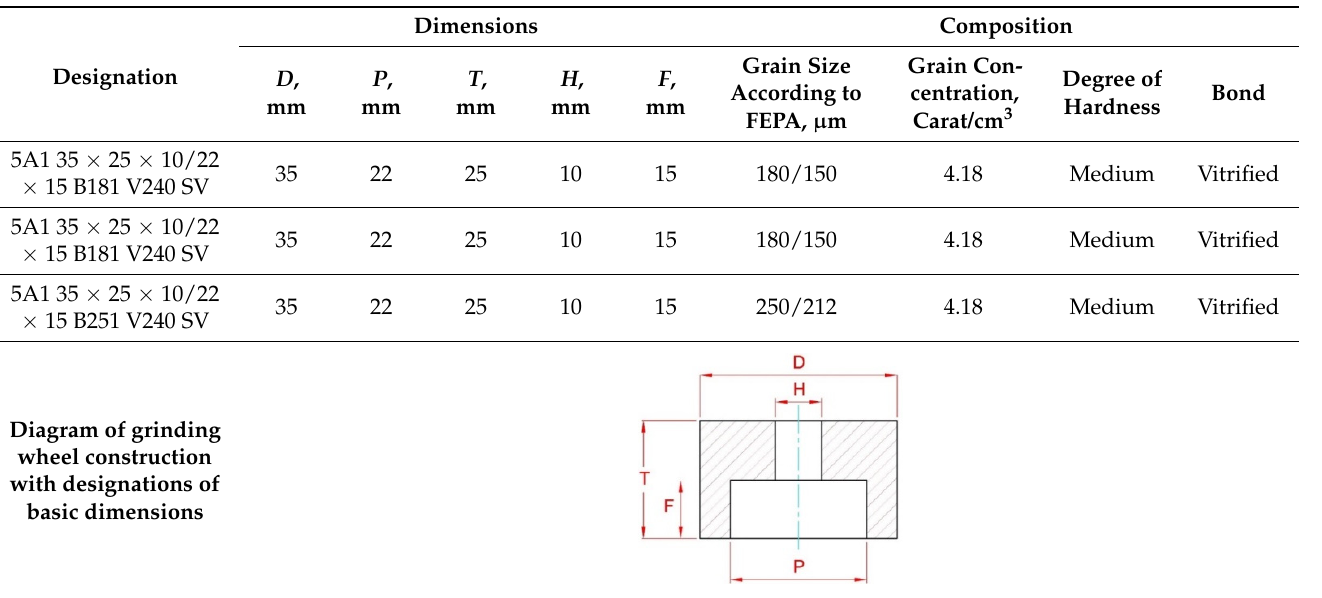
Table 2. Designation and main technical parameters of the grinding wheels [17].